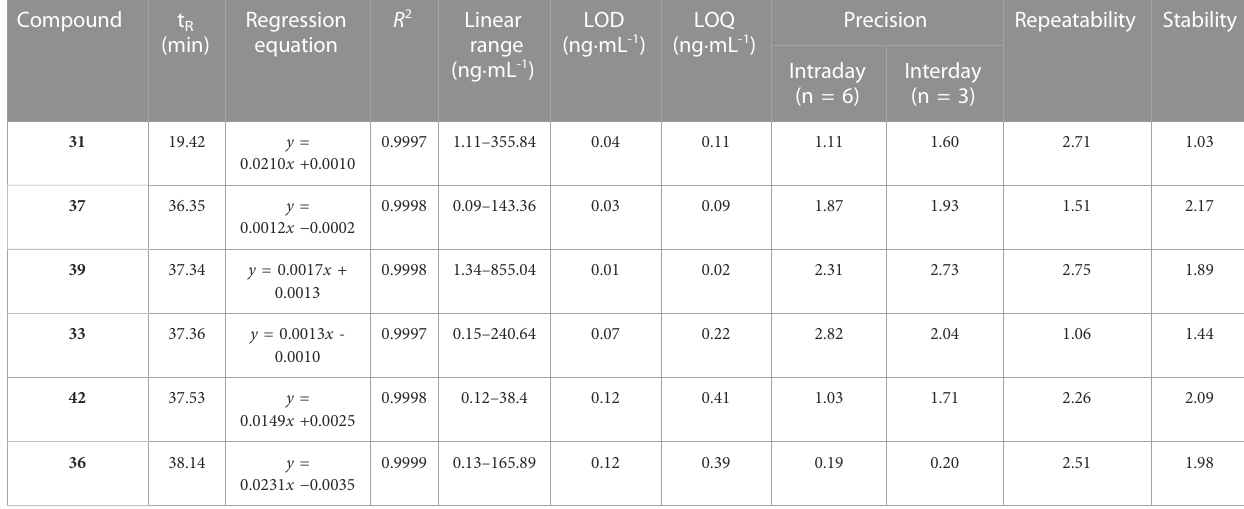
TABLE 2 HPLC-QqQ-MS detection parameters, regression equations, linear range, precision, repeatability, and stability of six alkaloids.